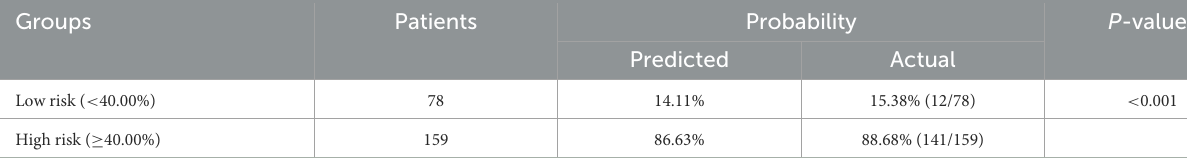
TABLE 5 Patients stratified by risk group based on the optimal threshold of the nomogram.